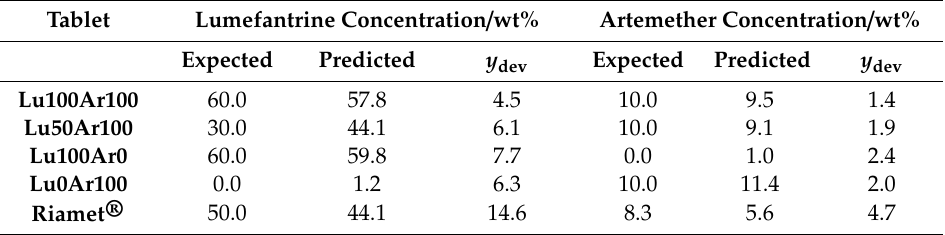
Table 2. Predictions of the lumefantrine and artemether concentrations in the model tablets and